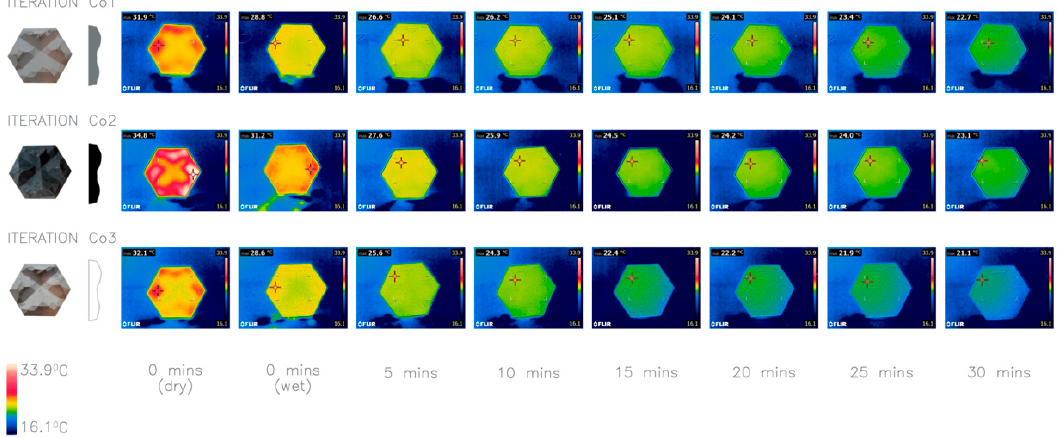
Figure 8. Thermal imaging of investigation 5: comparison of three iterations Co1–Co3 with different colors. Average heat loss after 30 min: Co1 9.1 °C, Co2 10.47 °C, Co3 8.8 °C.